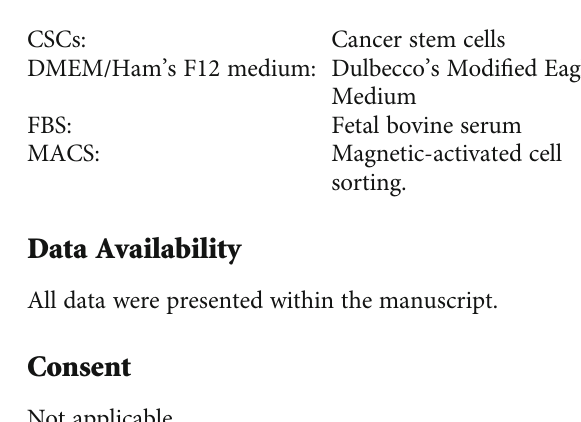
Supplementary 1 . Figure S1. Distribution of tumor properties. Mean tumor mass, necrosis area, and mitotic counts were presented on violin graphs in order to illustrate its distribu- tion between tested groups (CD133+ vs. CD133-). Supplementary 2 . Figure S2. Evaluation of mitotic index. Mitosis examples (arrow) in tumors depending on the phe- notype and number of implanted cells, light microscope, bar = 50 μ m . Supplementary 3 . Table S1. Detailed distribution of tumori- genesis in vivo depending on the expression of the CD133 marker and the number of implanted